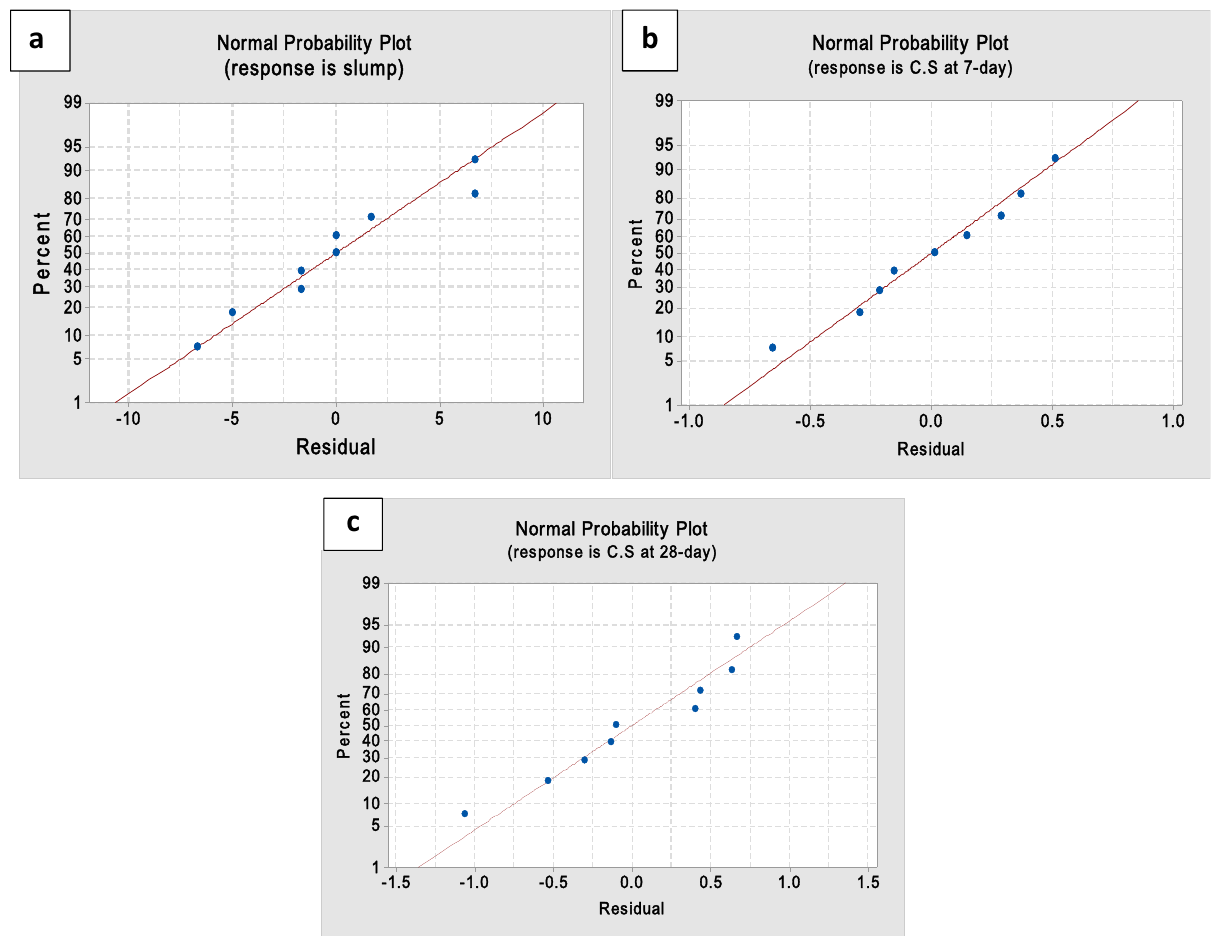
Figure 5: Normal probability plot for ( a ) slump, ( b ) CS at 7 days, and ( c ) CS at 28